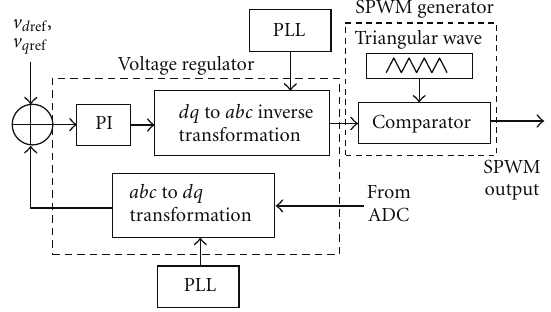
Figure 3: Block diagram of the voltage control scheme imple- mented in the dSPACE DS1104 controller